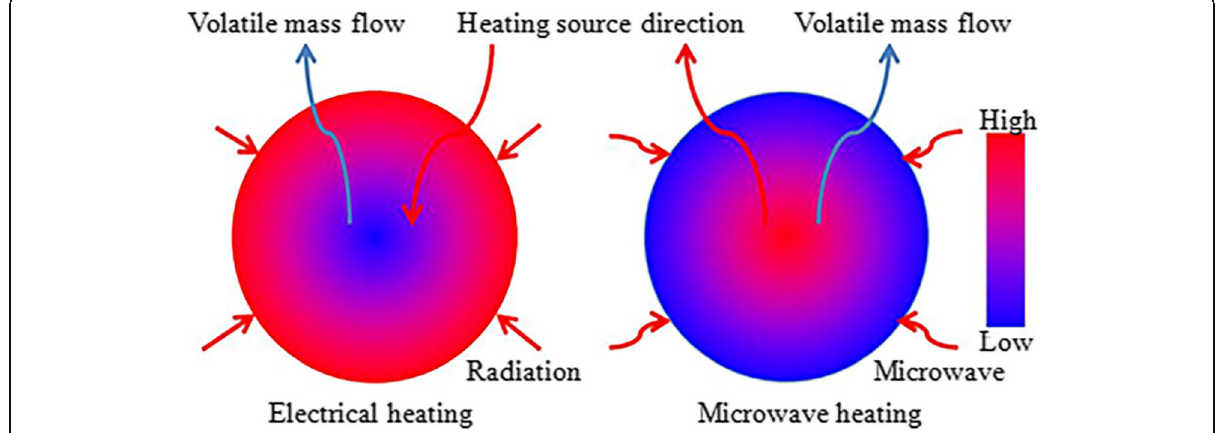
Fig. 1 Schematic diagram of temperature in conventional heating and microwave heating